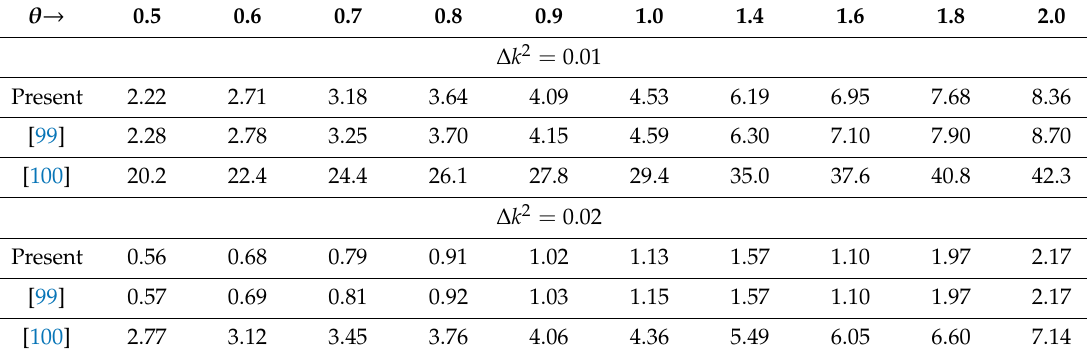
Table 24. Comparison of the presently calculated absorption coe ffi cients (10 25 cm 4 / dyne) with those obtained in [99] and [100].